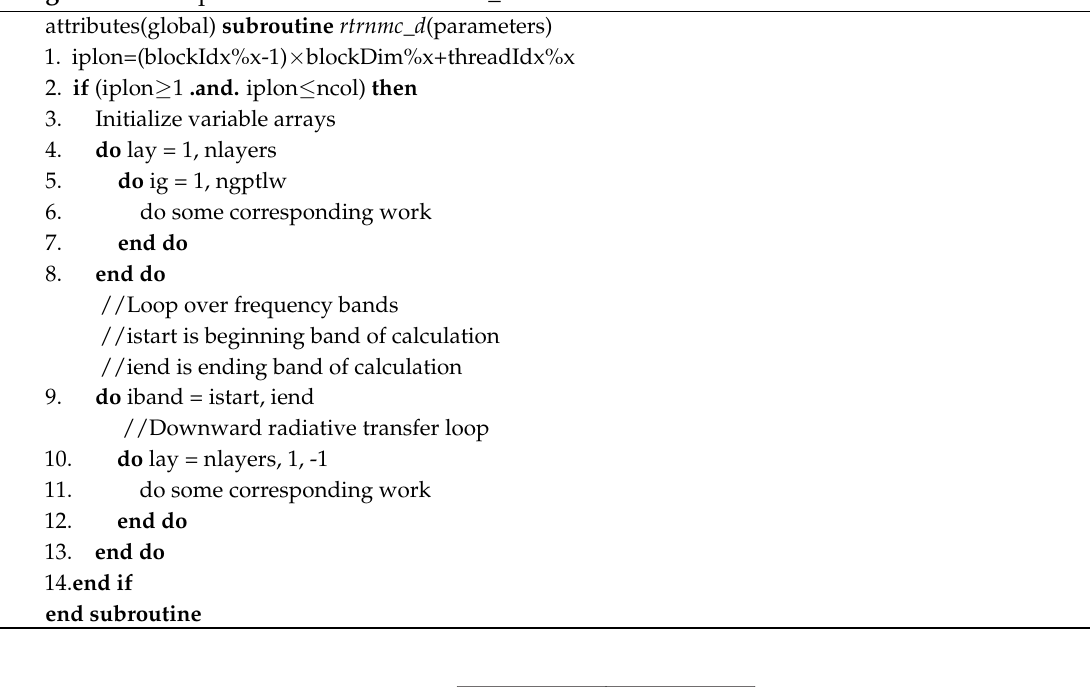
Algorithm 3: Implementation of 1D rtrnmc_d .